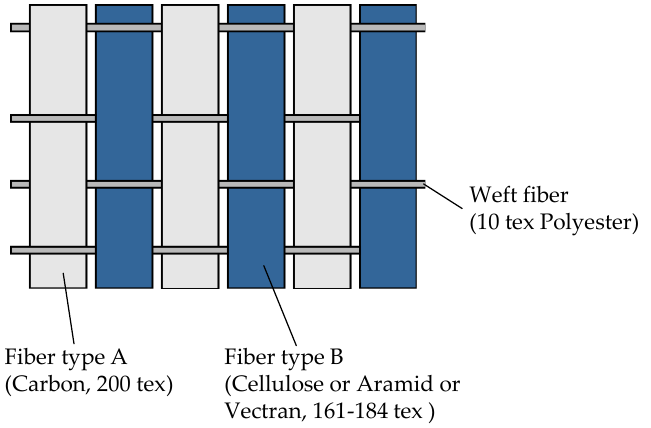
Figure 2. Construction of unidirectional hybrid textiles.